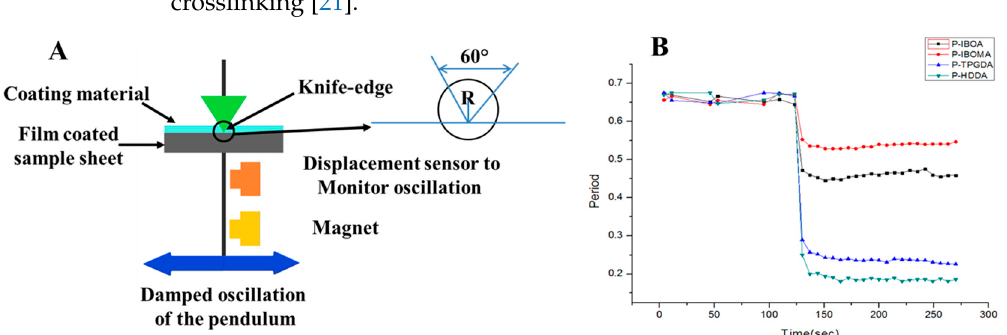
8 of 17 Figure 4. FT-IR spectra of P-IBOA coatings (before and after curing). Curing behavior is a significant characteristic for the PCM, and it provides crucial information on curing conditions. Rigid-body pendulum physical property testing in- strument (RPT) was used to identify the changes of property arising from curing from liquid to solid, which induces damped oscillation [20]. The RPT detects the curing be- havior of the coatings on the steel substrate as a function of UV irradiation. The curing density of coatings can be estimated indirectly by assessing vibration at the point where curing proceeded to the free-damped oscillation of the pendulum. The bigger the slope is, the faster the reaction velocity is facilitated, and the deeper the depth, the higher the